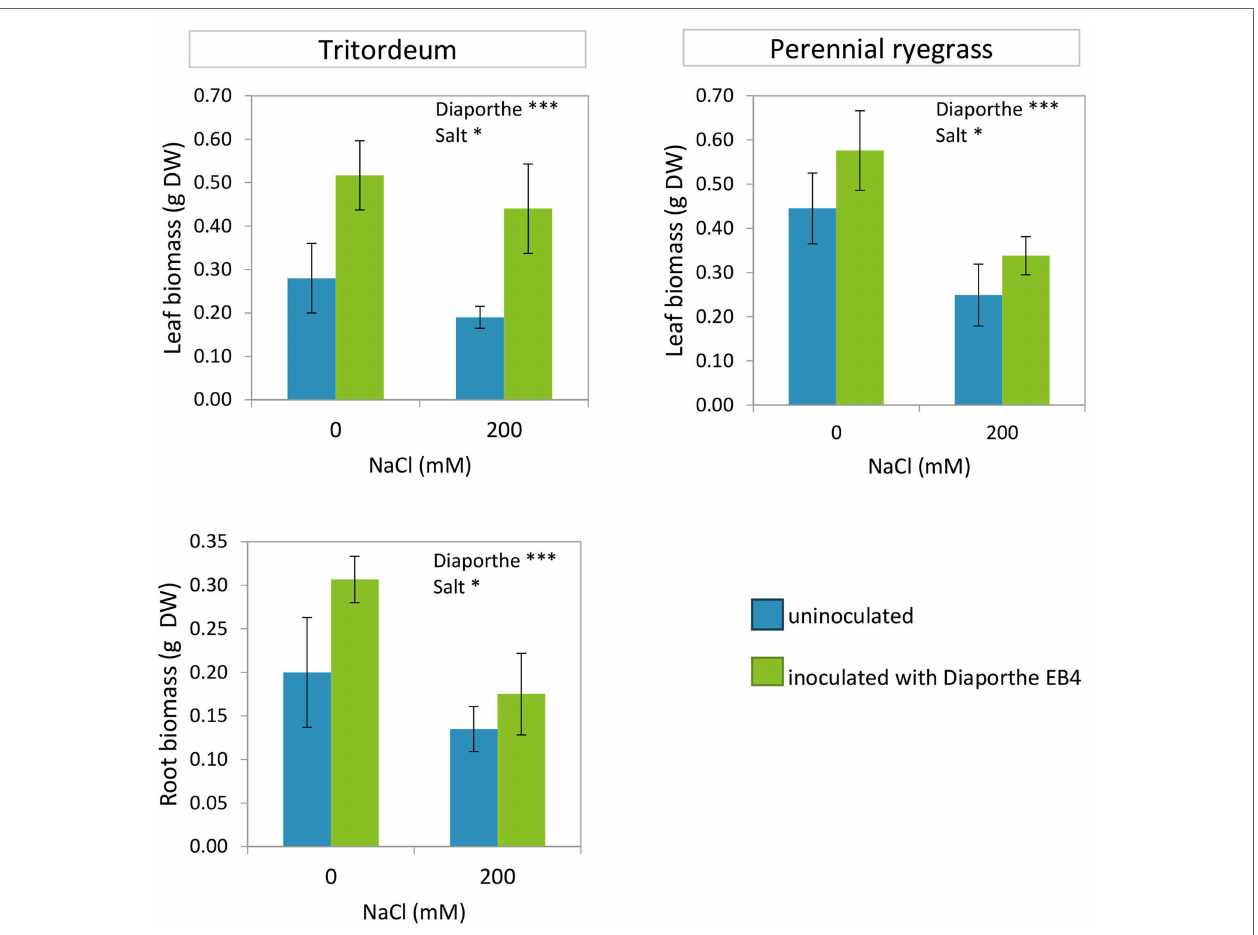
FIGURE 1 | Leaf and root dry weight in tritordeum and perennial ryegrass plants not inoculated ( BLUE ) or inoculated with Diaporthe EB4 ( GREEN ), at two different salinity treatments (0 and 200 mM NaCl). Values are means ± SD ( n = 12). Roots of perennial ryegrass were not collected and measured. Significant effects of “ Diaporthe inoculation” and/or “salinity” are indicated as * p < 0.05; *** p <